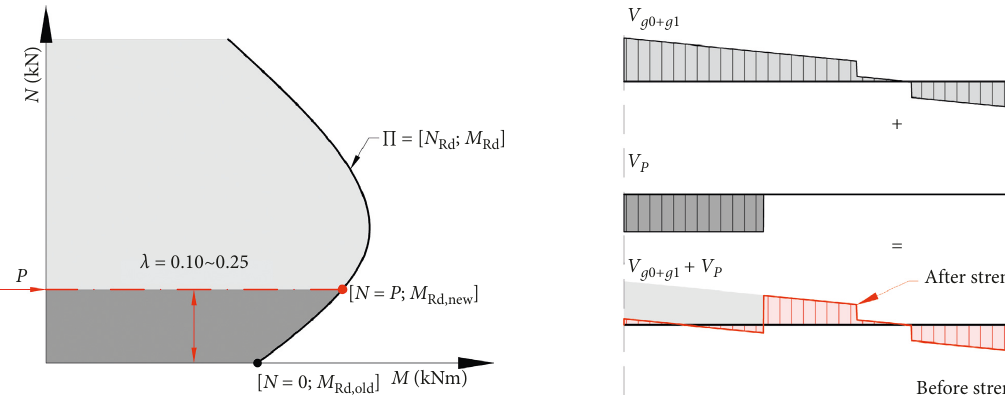
Figure 13: Increase of the load-bearing capacity of the cross section in the interval of partially prestressed concrete λ � 0 . 12 ∼ 0 . 25 expressed by the interaction diagram (failure function π